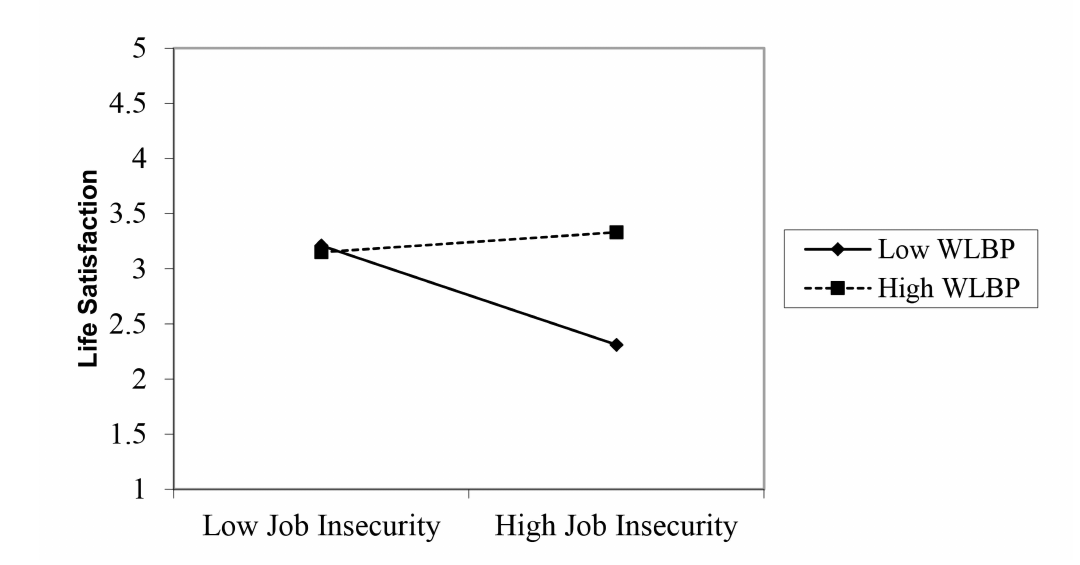
Fig. 3. The multilevel moderating effect of